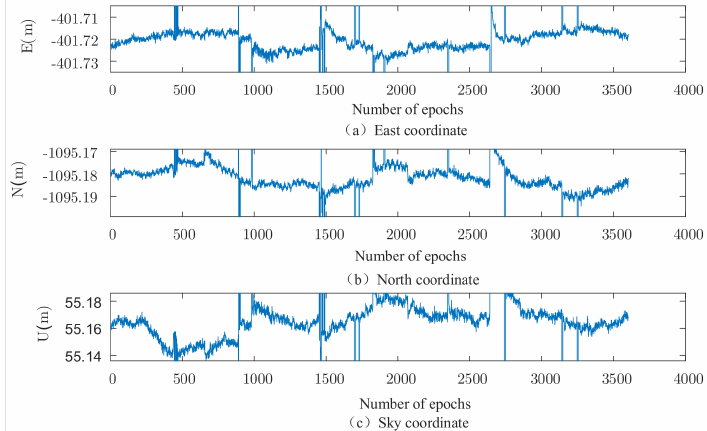
Figure 4. Measured data 2, three-dimensional baseline results of traditional EKF.